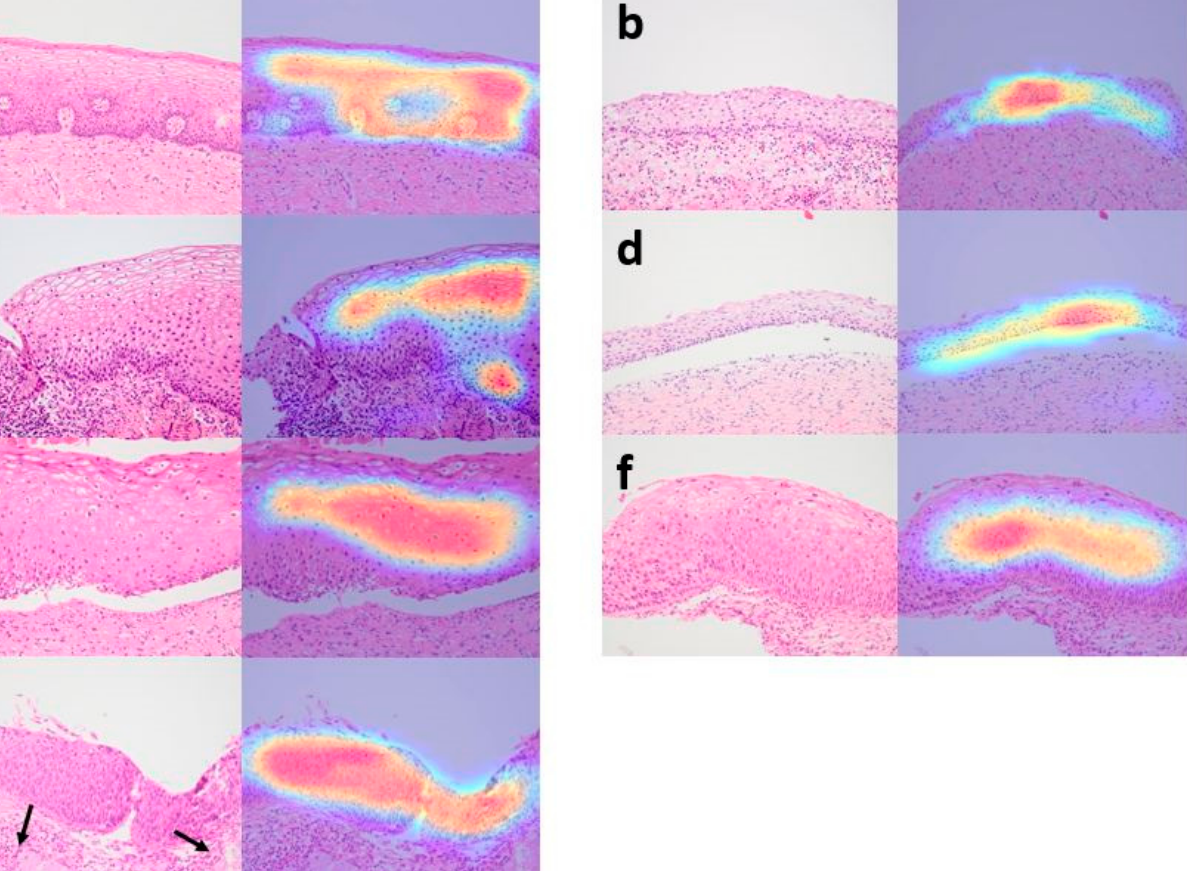
Figure 5. Grad-CAM images by EfficientNet-B7. Normal squamous epithelium was highlighted in Grad-CAM images ( a – d ). Images from cervix interpreted as non-neoplasm by the EfficientNet-B7 include exocervix ( a ), metaplastic muco-sa from transformation zone ( b ), cervicitis and erosion ( c ) and atrophic mucosa ( d ). In CIN1, layers with koilocytotic cells were mainly highlighted ( e ). The highlighted areas extended to the upper two-third of the epithelium in CIN2 ( f ) and full-thickness of the epithelium in CIN3 ( g ). Normal endocervical glands (( g ), black arrows) were not highlighted.